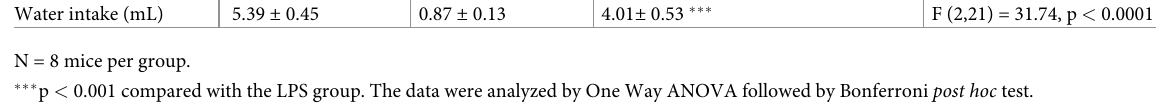
behaviors in mice. The use of such assessments further opens new doors to pharmacological research in inflammation and pain and holds promise for pharmacological screening of poten- tial anti-inflammatory and analgesic drug candidates. While home-cage behaviors constitute only a limited aspect of pain behaviors, a combination of reflexive and non-reflexive approaches presents an excellent opportunity to create a more holistic picture of pain behav- iors. Our results establish a potential framework for quantitative and objective assessments of sickness behaviors along with pain-like behaviors in LPS-induced inflammatory mice.